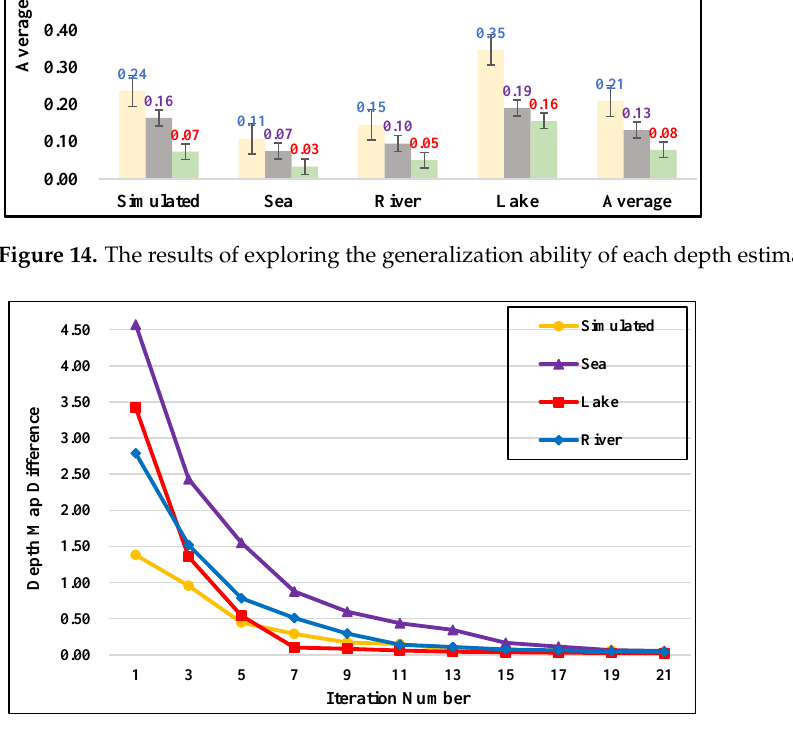
Figure 15. The converging curve of the self-improving procedure for all the